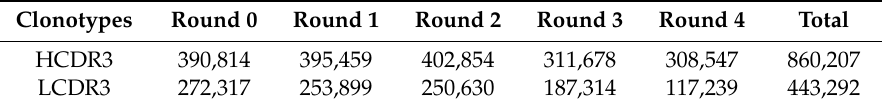
Table 1. Number of CDR3 clonotypes obtained from the bio-panning